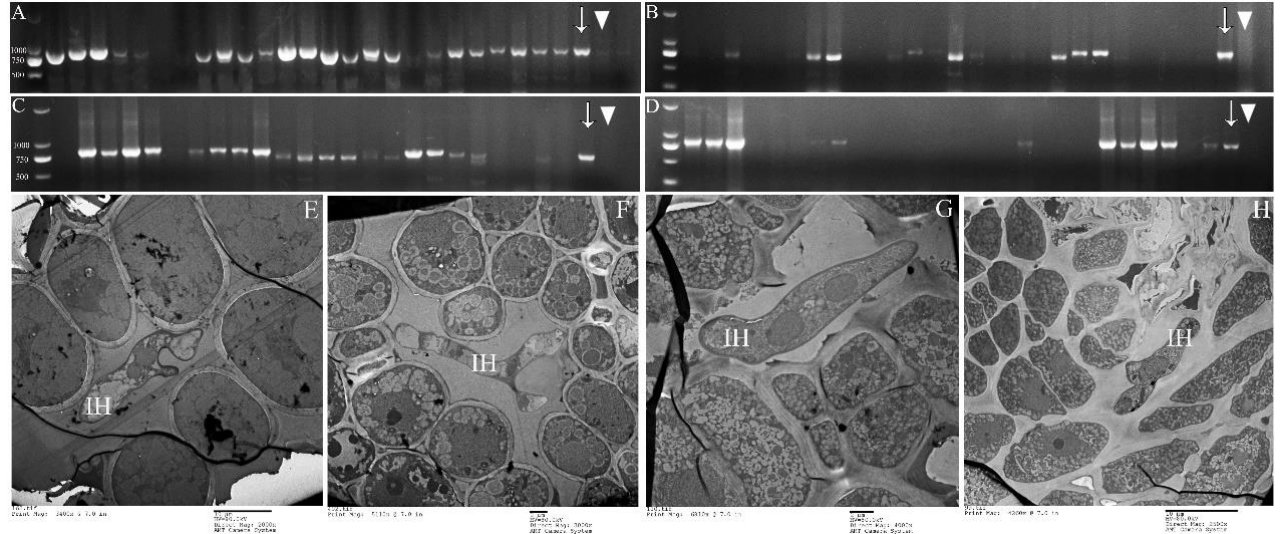
Figure 9. Mycelium detection in buds of P. tomentosa and P. euphratica . ( A , B ): PCR detection for P. tomentosa buds; ( C , D ): PCR detection for P. euphratica ; ( E , F ): TEM detection for P. tomentosa buds ;